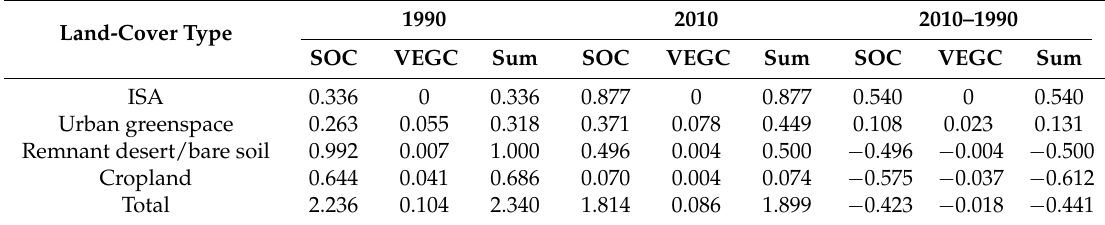
Abbreviations: SOC—soil organic carbon; VEGC—vegetation